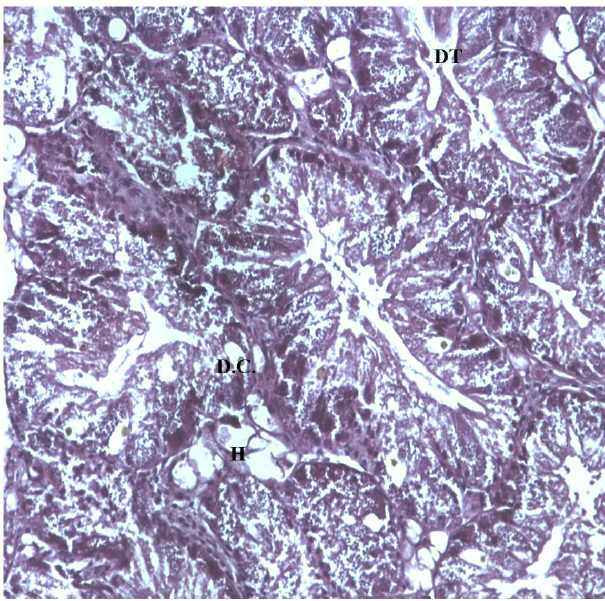
Fig. 5. Histological section of the Helix muller snail 14 days after wakening. Magnification 10×/0.25. D.T. – diges- tive tubules, D.C. – digestive cells, H –